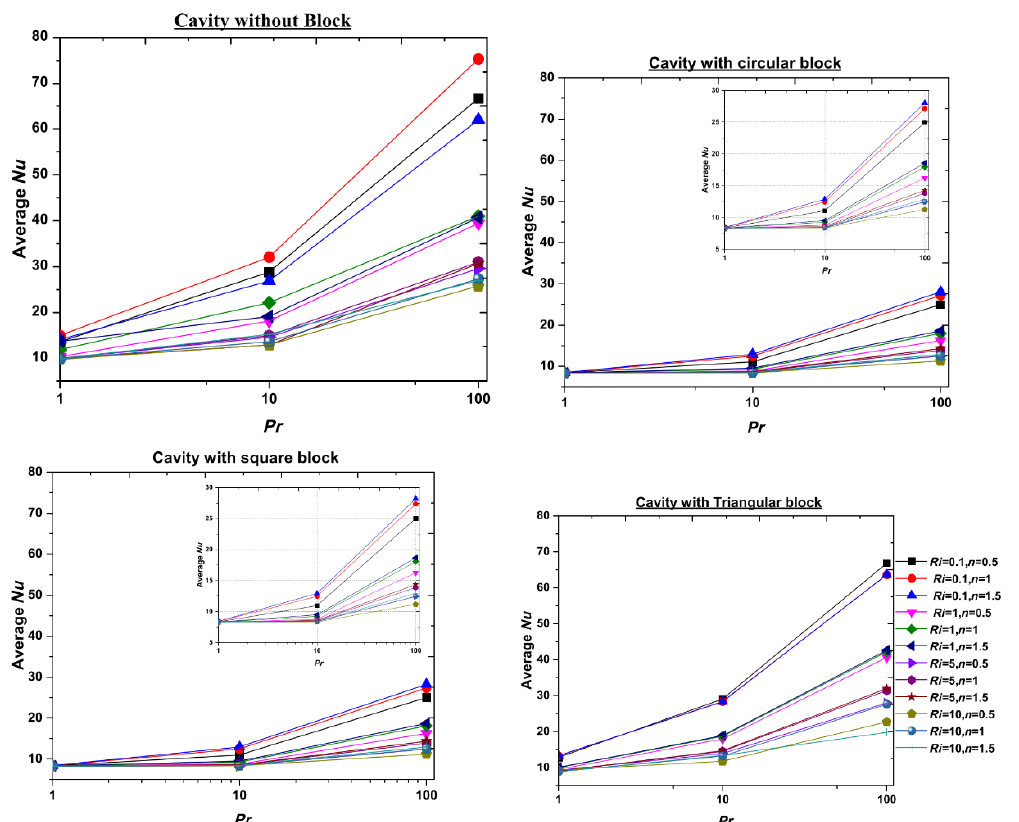
Figure 2. Variation of average Nusselt number with the Prandtl number in a semi-circular cavity with no block. Reprinted with permission from Ref. [17]. 2020, Elsevier.